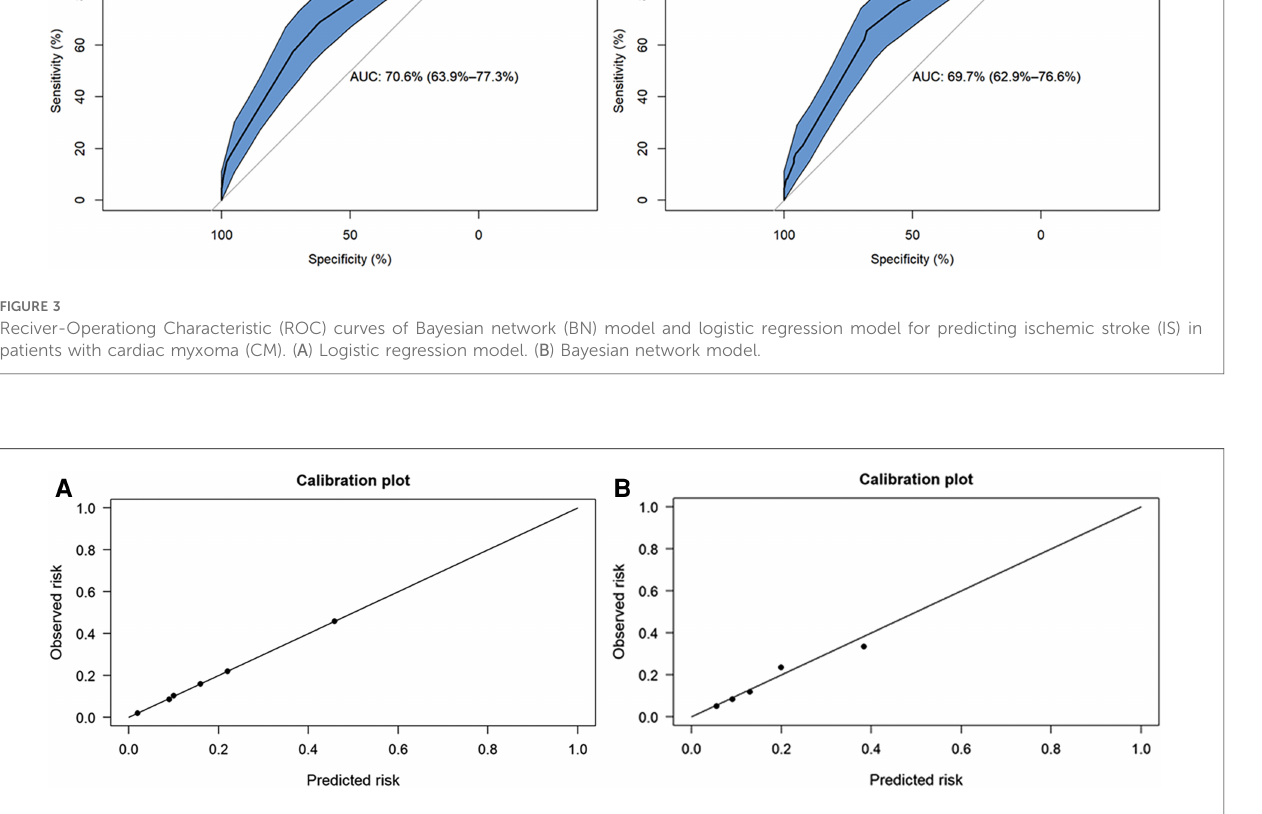
FIGURE 4 The performances of Bayesian network (BN) model and logistic regression model for predicting ischemic stroke (IS) in patients with cardiac myxoma (CM). ( A ) Logistic regression model. ( B ) Bayesian network